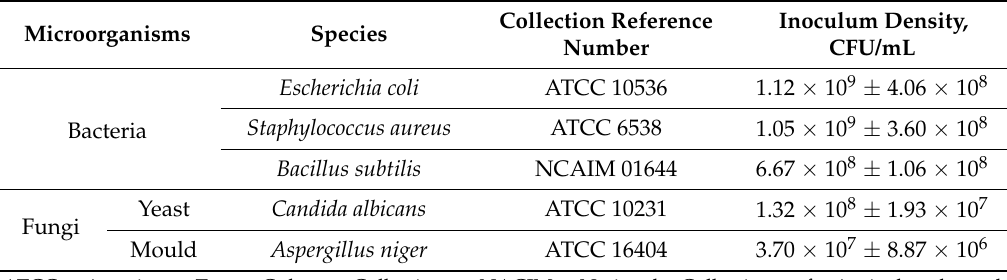
Table 2. Characteristics of